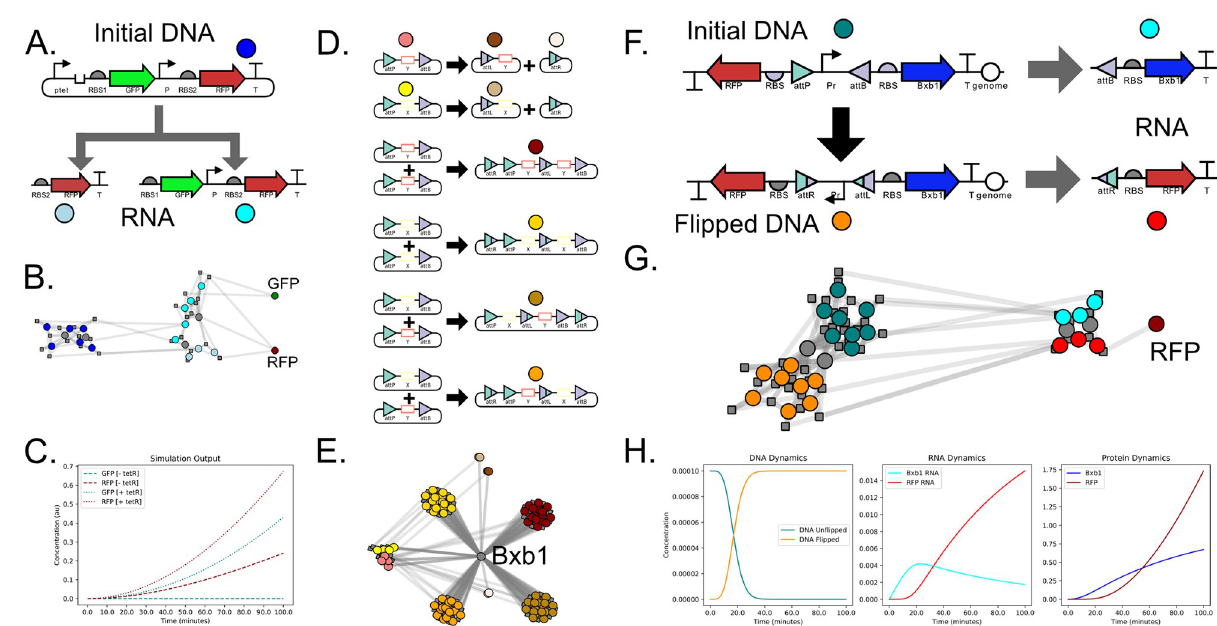
Fig 6. Examples involving component enumeration. A . Schematic of local component enumeration for a gene expression circuit where a single DNA Component generates multiple RNA Components . B . The CRN for (A) represented graphically. Colored dots are species corresponding to the components adjacent to the dots in (A). C . Simulated output from the CRN in (B). D . Schematic of global component enumeration in an integrase circuit where one or more DNA Components recombine to produce new DNA Components . Note that the larger DNA outputs could also recombined analogously but this is not shown. E . The CRN for (D) represented graphically. Colored dots are species which correspond to the components adjacent to the dots in (D). F . A genetic circuit which combines global and local component enumeration to flip a promoter which drives gene expression. G . The CRN for the circuit in (F). Colored dots are species representing the components adjacent to the dots in (F). H . Simulated output of the CRN.